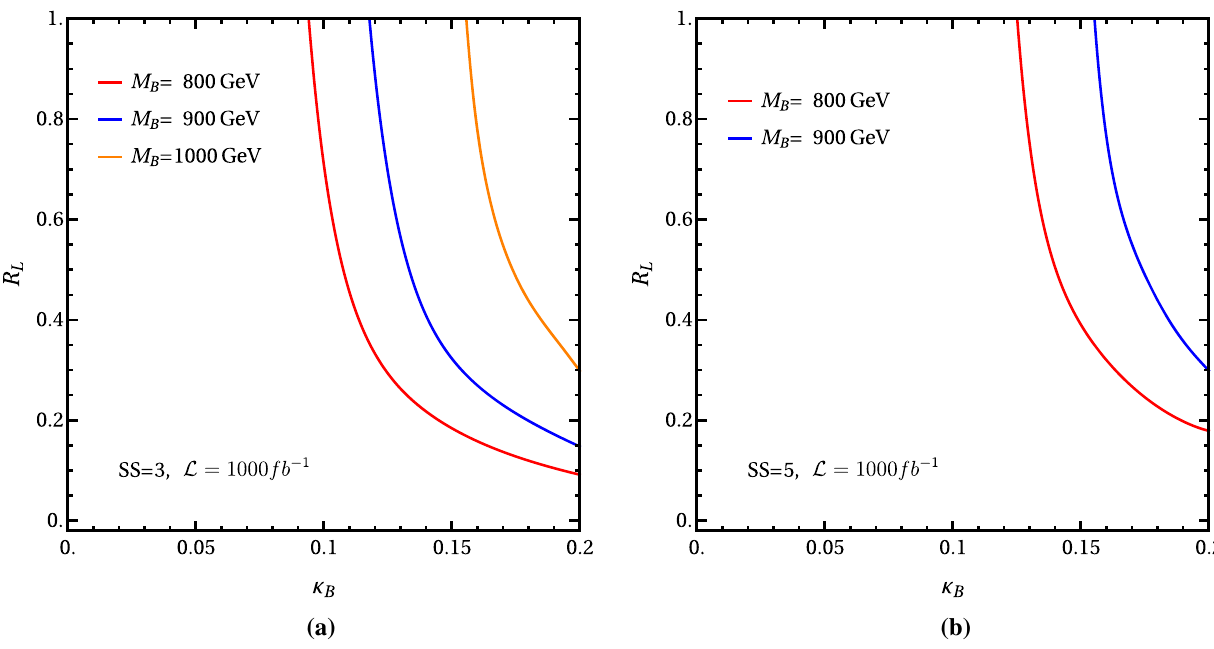
Fig. 8 Same as Fig. 5, but for the fully leptonic channel